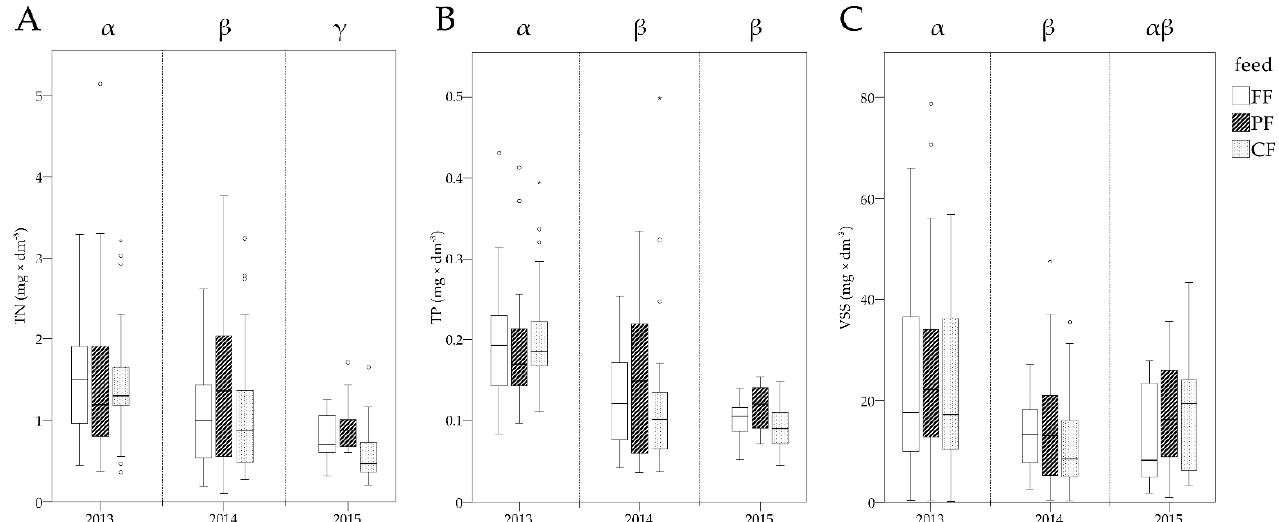
Figure 2. Water quality changes between years and treatments (FF: feed with fish meal, PF: plant-based feed, CF: cereal feed), indicated by total nitrogen ( A ), total phosphorus ( B ), and organic material (measured as volatile suspended solids—VSS) ( C ) concentrations. The different Greek letters ( α , β , γ ) represent statistically significant ( p < 0.05) differences between the years for the given water quality variable. Tests and figures were generated by the IBM SPSS software package (version 25).